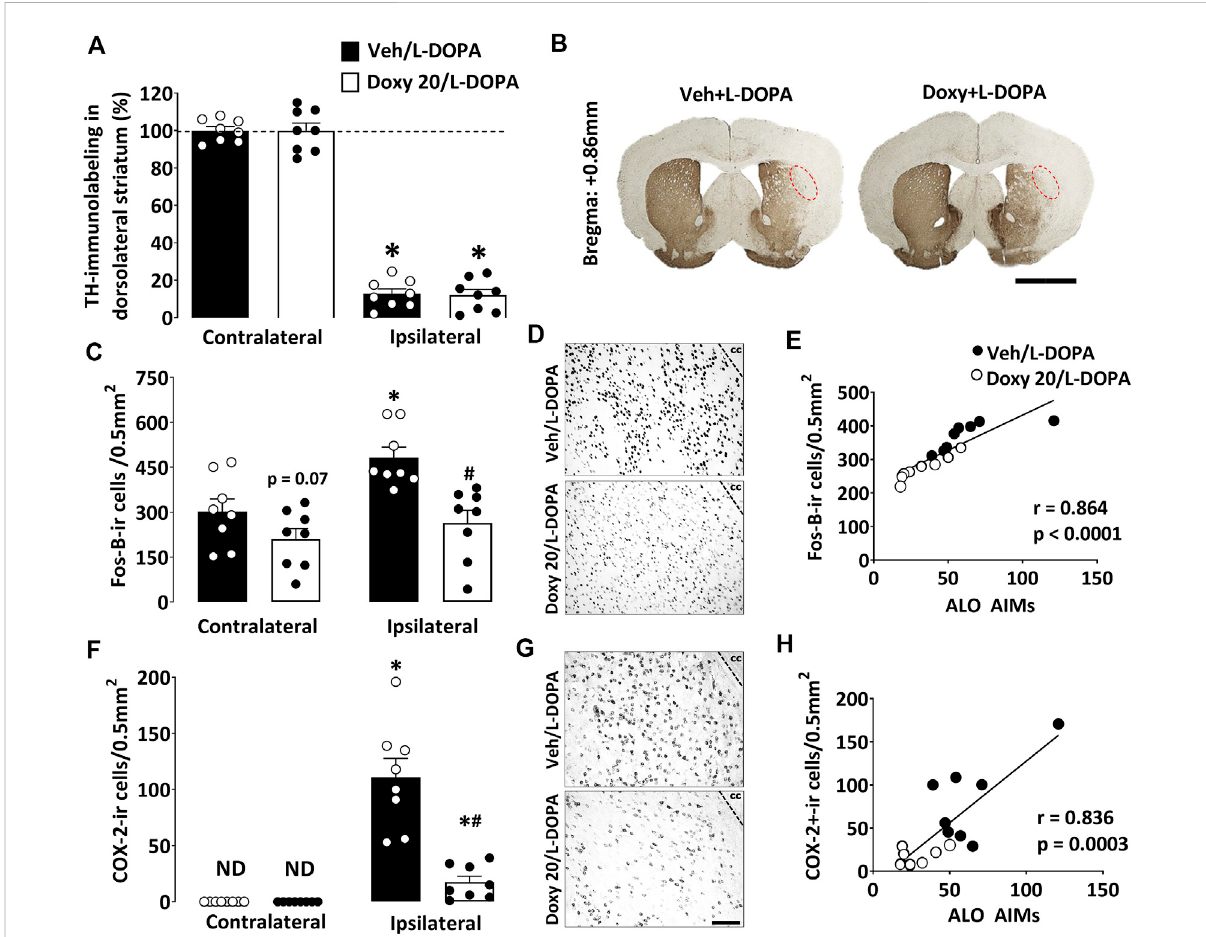
Analysis of the impact of Doxy treatment on TH, Fos-B, and COX-2 expression within the dorsolateral striatum of mice with partial lesions. (A) Quantitative optical density of striatal TH immunolabelling in coronal sections of the striatum of lesioned mice treated or not with 20 mg kg − 1 . (B) Photomicrographs of coronal sections of the rostral striatum illustrate that the loss of TH immunosignal is limited to the dorsolateral area of the striatum. (C) Chronic treatment with L -DOPA increased Fos-B expression in the lesioned mice ’ s dorsolateral area of the striatum, and co- treatment with 20 m kg − 1 Doxy signi fi cantly reduced the number of Fos-B + cells. (D) Representative photomicrographs of Fos-B-ir cells in the dorsolateralstriatum of Veh/ L -DOPA andDoxy/ L -DOPA-treated mice. (E) Positive correlationbetweentheintensity ofAIMs and Fos-B expression in lesioned mice treated with Veh or Doxy + L -DOPA. (F) The number of COX-2 + cells increased mainly in the dorsolateral striatum of lesioned mice after L -DOPA treatment and co-treatment with 20 m kg − 1 Doxy signi fi cantly reduced the number of these cells. (G) Representative photomicrographs describing COX-2-ir cells in thelesioned striatum of Veh/ L -DOPA and Doxy 20/ L -DOPA-treated animals. (H) Positivecorrelation between the intensity of AIMs and the number of COX-2 + cells in mice treated with Veh or Doxy + L -DOPA. a, c and (F) * p < 0.05 vs unlesioned side; Two-way ANOVA followed by Bonferroni analysis, n = 8/group. e and (H) Spearman correlation. Values are presented as mean ± SEM. cc: corpus callosum. ND: non-detectable. The red dashed line area corresponds to the striatum portion in which TH, Fos-B, and COX-2 were quanti fi ed. Scale Bar = 1 mm (B) and 50 µm (D – G)